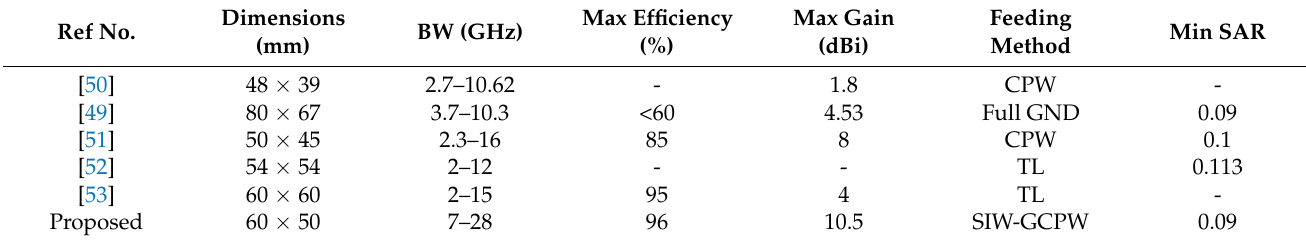
Table 4. Proposed antenna’s performance comparison with similar